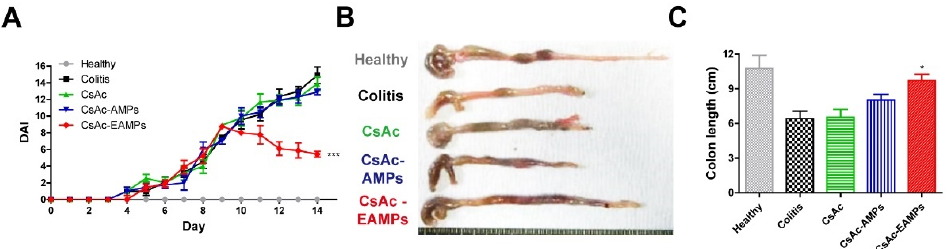
Figure 3. Macroscopic evaluation of colitis. ( A ) Changing profiles of disease activity index (DAI). ( B ) Representative colon image on day 14 (last day of the experiment). ( C ) Colon length. * and *** denote p < 0.05 and p < 0.001 compared to the colitis group. The results are expressed as means ± standard deviation ( n = 8). CsAc, cyclosporine A crystals; CsAc-AMPs, CsA crystal-loaded alginate microparticles; CsAc-EAMPs, CsA crystal-loaded, Eudragit S 100 coated alginate microparticles.